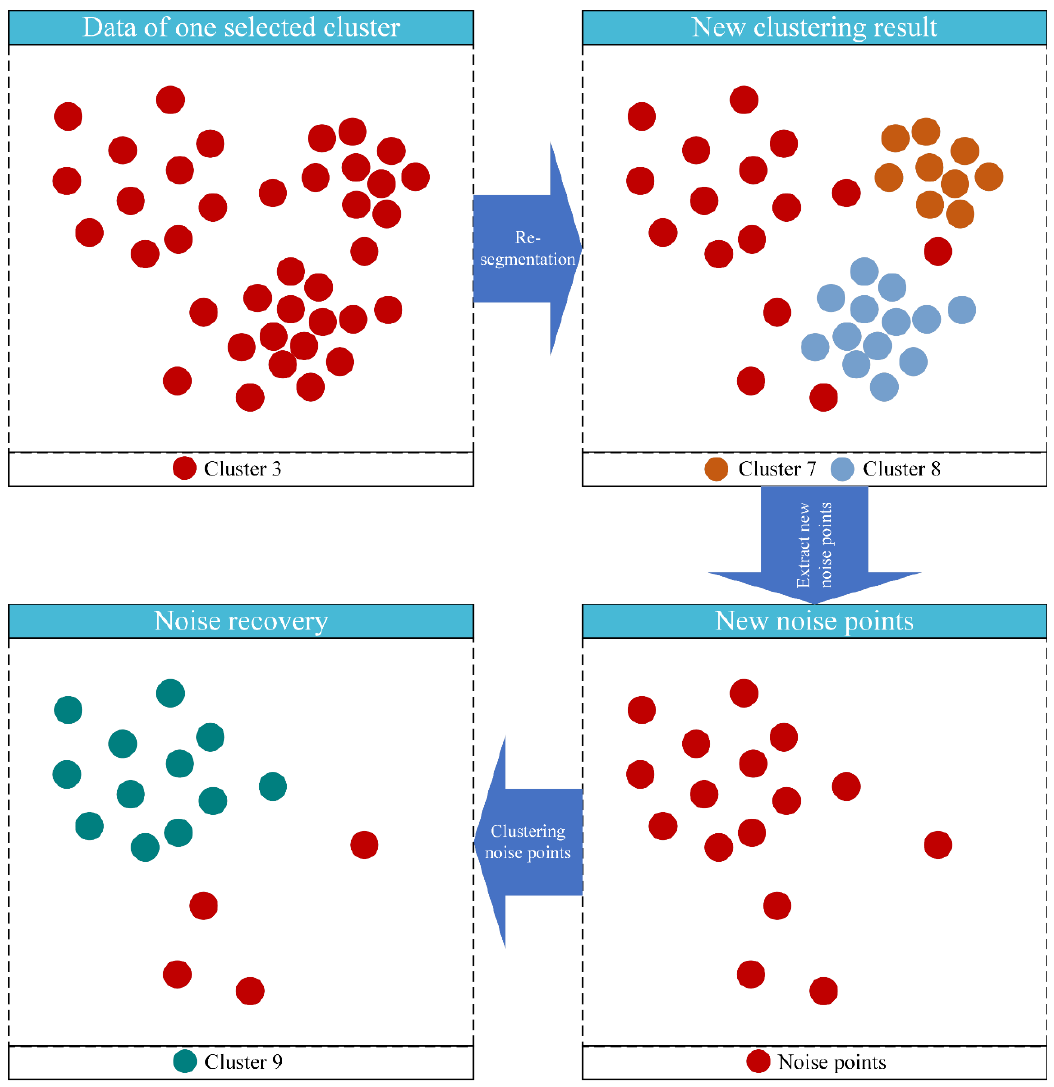
Figure 8. Noise recovery using the re-segmentation result of Cluster 3. There are two new clusters and lots of noise points after re-segmentation. Then, new noise points are clustered again and com- bined with Clusters 7 and 8 to update the clustering